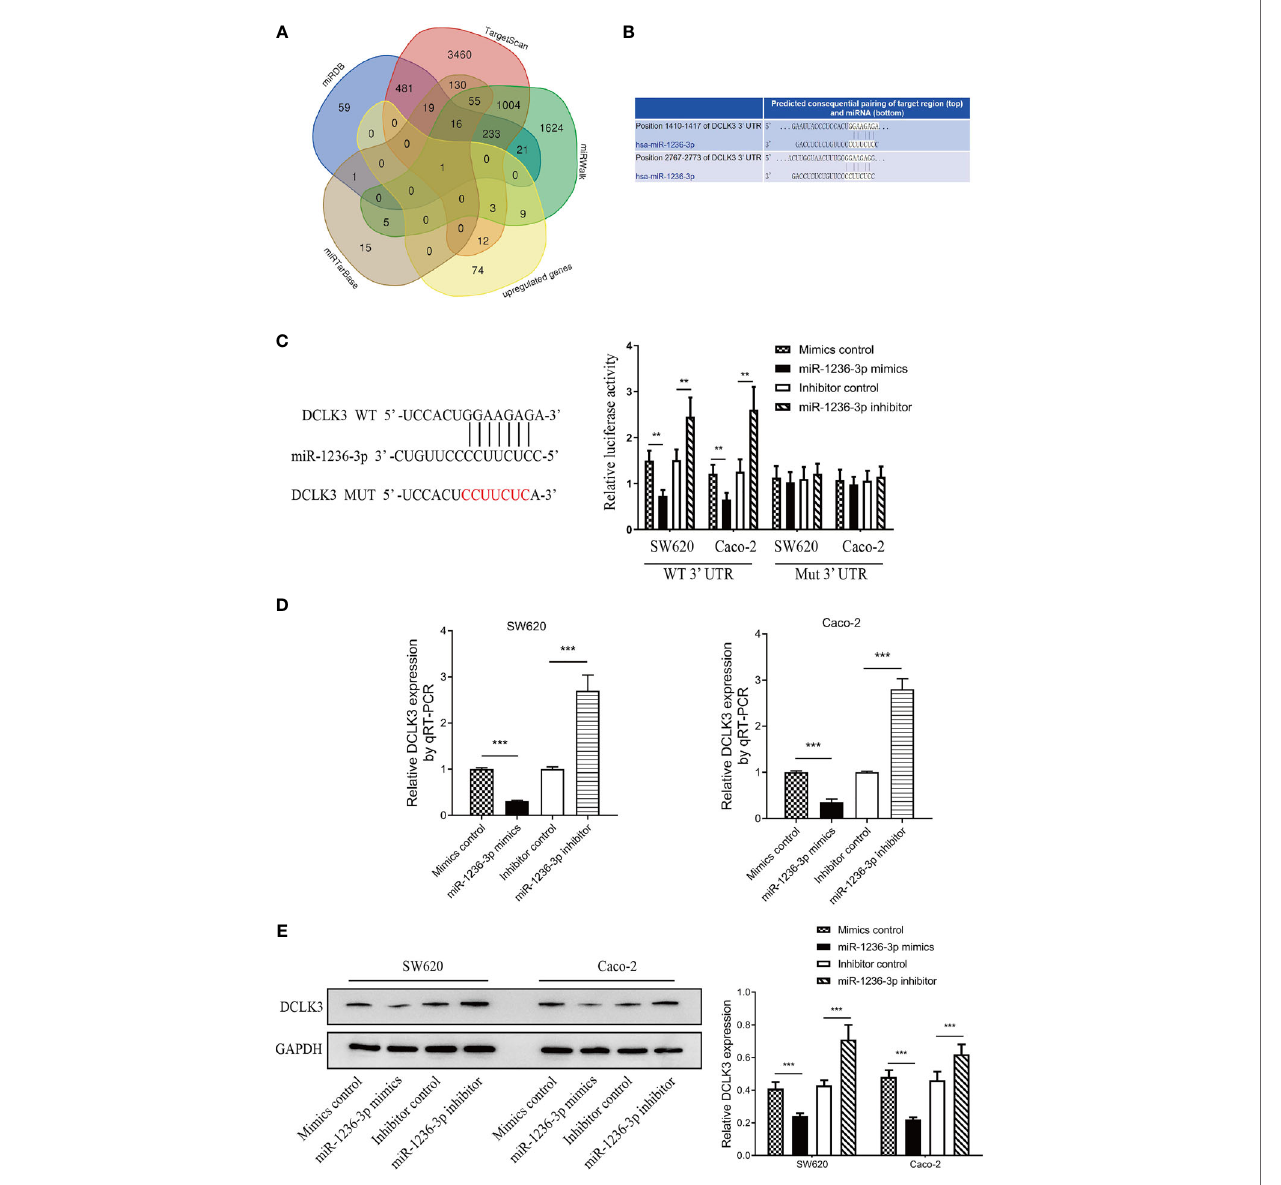
FIGURE 6 | Identi fi cation of DCLK3 as the target gene of miR-1236-3p. (A) Identi fi cation of DCLK3 as the target gene by vein result using upregulated genes and four online target-predicting algorithms (TargetScan, miRDB, miRWalk, and miRTarBase). (B) The binding sites of DCLK3 and hsa-miR-1236-3p by TargetScan. (C) Luciferase reporter activity after transfections (mimic control, miR-1236-3p mimic, inhibitor control, and miR-1236-3p inhibitor) in SW620 and Caco-2 cell lines. The results of qRT-PCR (D) and western blotting (E) indicated that miR-1236-3p mimic decreased the DCLK3 expression, while miR-1236-3p inhibitor increased the DCLK3 expression in both SW620 and Caco-2 cell lines. qRT-PCR, quantitative reverse transcription – polymerase chain reaction; Error bars represent the mean ± s.e.m. **P < 0.01, ***P < 0.001 by Student ’ s t-test, six replicates per